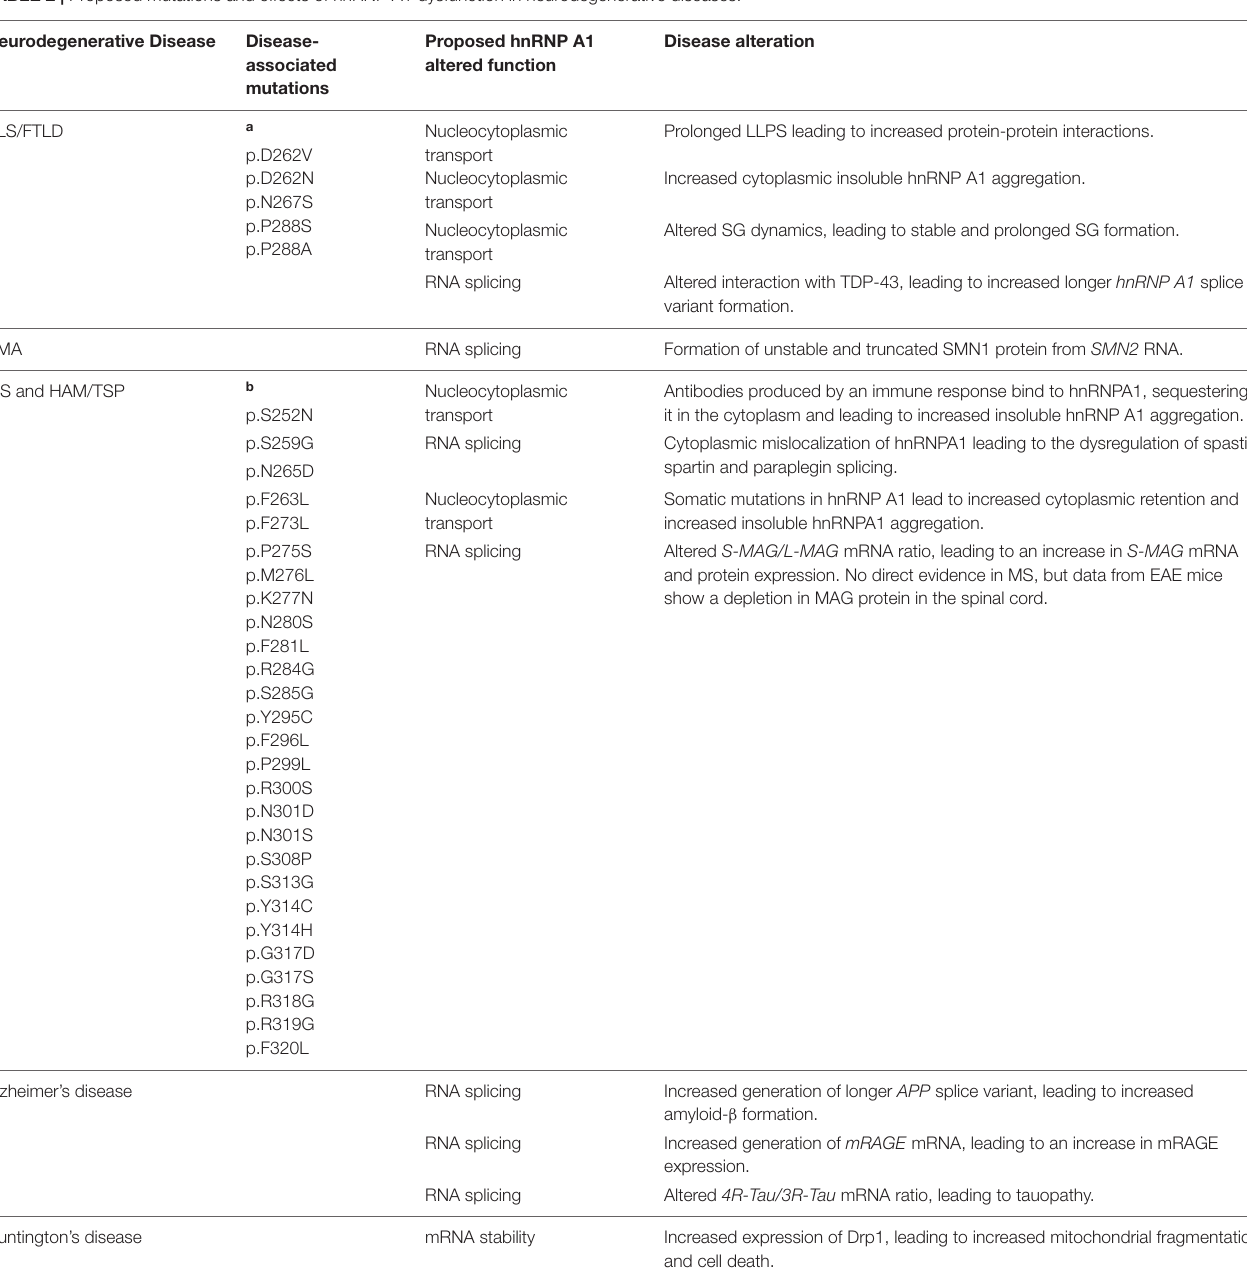
TABLE 2 | Proposed mutations and effects of hnRNP A1 dysfunction in neurodegenerative